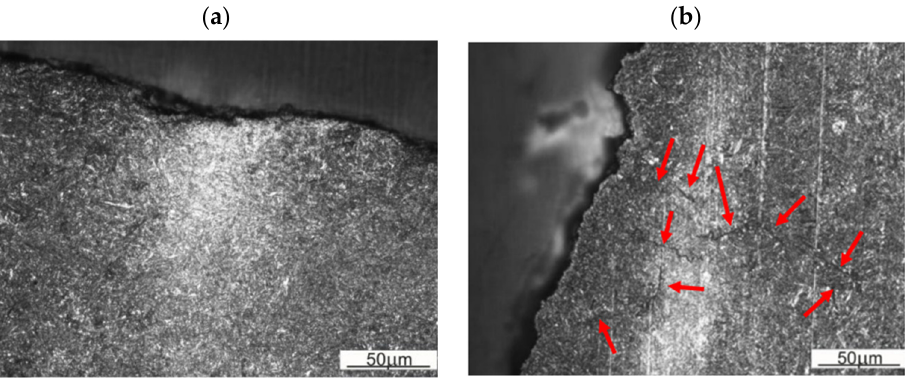
Figure 16. Microstructure of the forging die near the fracture surface: ( a ) fracture in the plane perpendicular to banding, ( b ) fracture in the plane parallel to banding. Red arrows indicate microcracks.